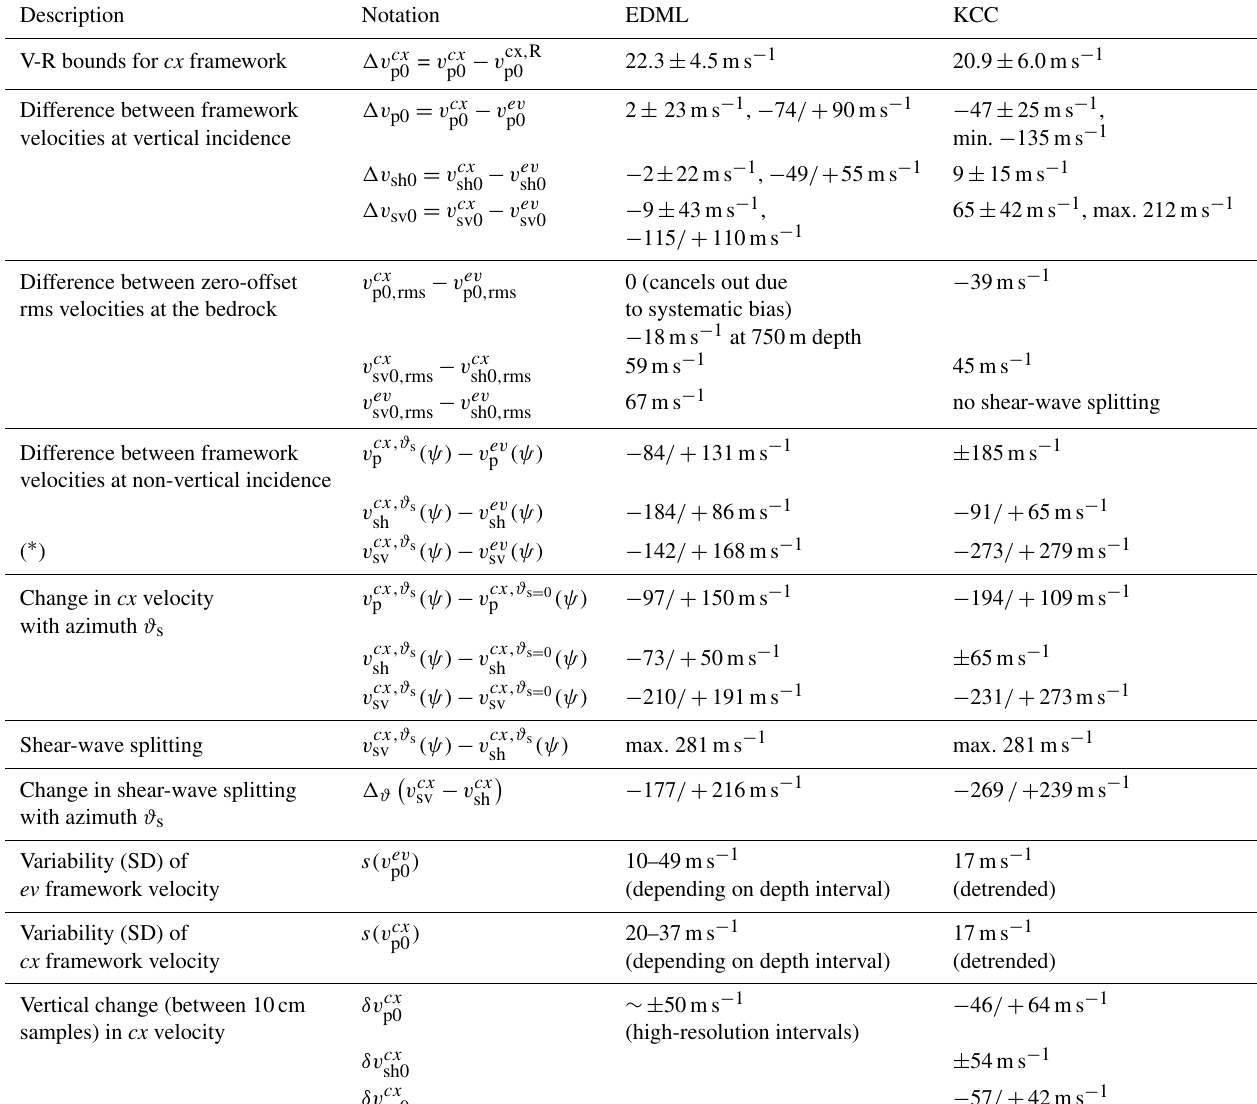
Table 2. Summary of the results from the seismic velocity comparison between frameworks. Values are calculated depth-profile average (with standard deviation) and/or extreme ( ± ) interval velocity differences (other than rms) for incidence angles of 0–70 ◦ . Negative values indicate smaller velocities from the cx framework relative to the ev framework. The reported extreme values can be influenced by outliers from the general